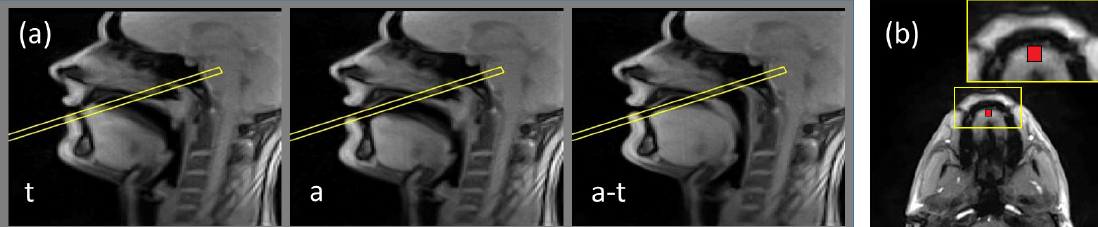
Figure 1. Illustration of the routine of the slice and region of interest positioning. ( a ) examples of frames of dynamic acquisition of the subject obtained with the real-time MRI sequence in the mid-sagittal plane: during production of /a/, of /t/ and transition between /a/ and /t/. The frame denotes the position of the slice touching the hard palate and perpendicular to the tongue motion direction; ( b ) example frame of the acquisition in the plane denoted by the frame in Figure 1a. Region of interest is shown by the rectangle. The inset presents zoomed-in region containing